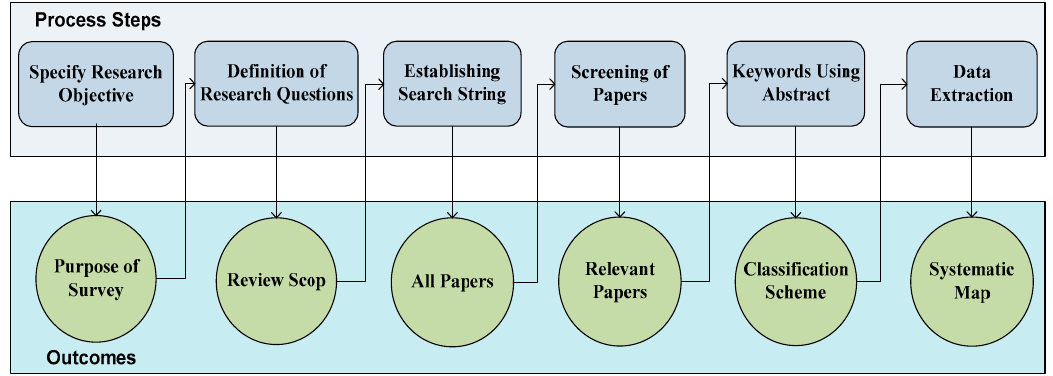
Figure 1. Research methodology .